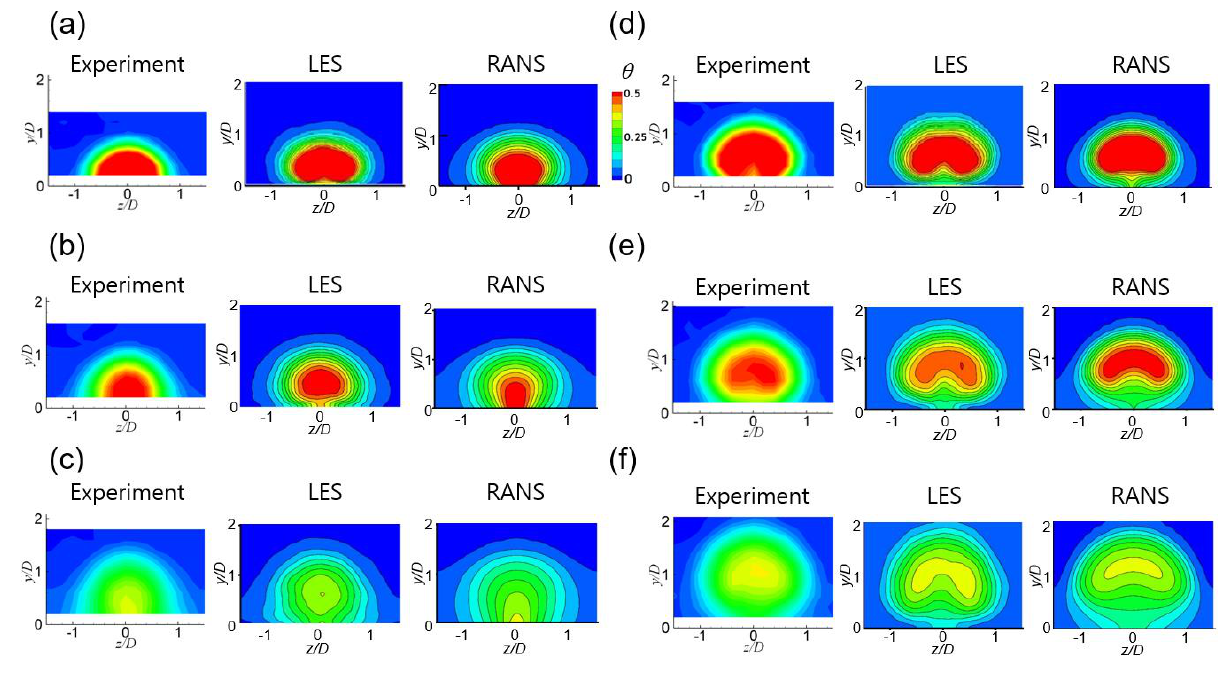
Figure 4. Boundary layer temperature distributions in the streamwise normal planes [5]: ( a ) x / D = 2.5, M = 0.5; ( b ) x / D = 5.0, M = 0.5; ( c ) x / D = 10.0, M = 0.5; ( d ) x / D = 2.5, M = 1.0; ( e ) x / D = 5.0, M = 1.0; and ( f ) x / D = 10.0, M = 1.0.